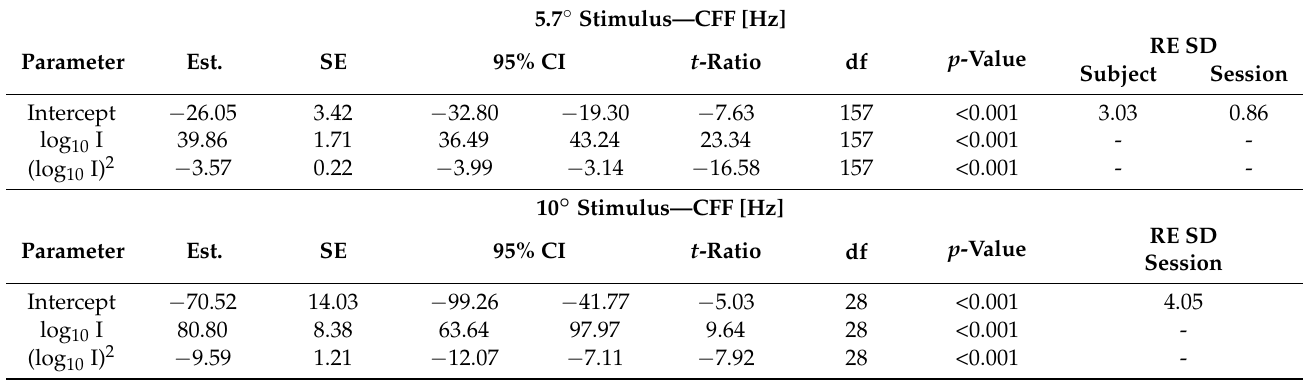
Table 2. Linear mixed model results of CFF as a function of log10 retinal illuminance and squared log10 retinal illuminance. The parameters estimate (Est.), their standard errors (SE) and 95% confi- dence intervals (95% CI) are shown, as well as the t-test results and the standard deviation of the different random effects included (RE